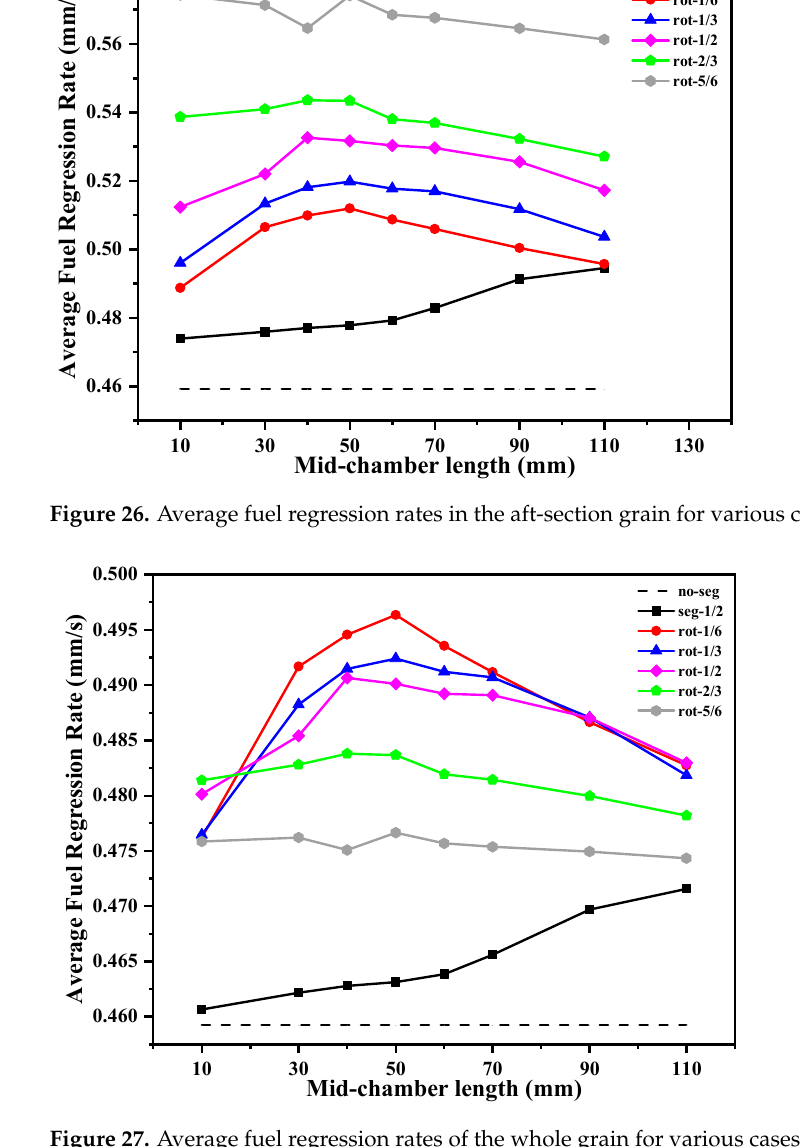
Figure 27. Average fuel regression rates of the whole grain for various cases.